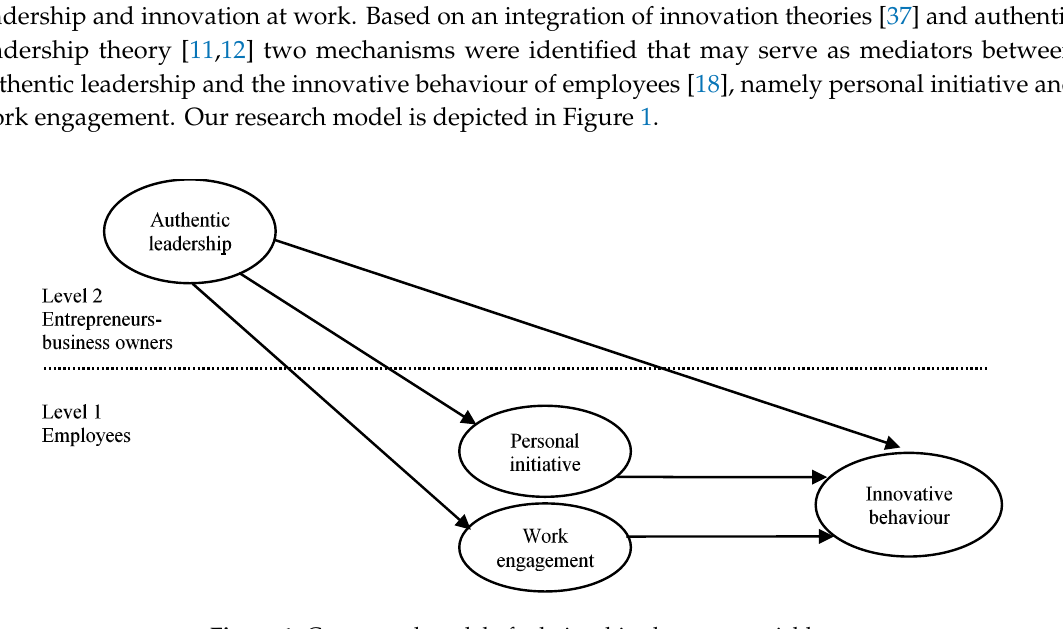
Figure 1. Conceptual model of relationships between variables.